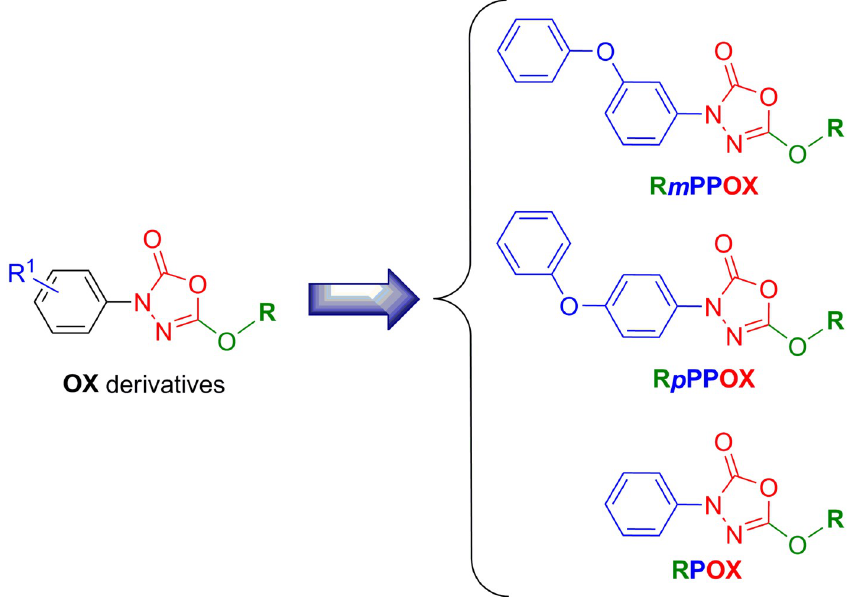
Fig 1. Chemical structure of the OX derivatives. R m (or p ) PPOX nomenclature is as follows: m (or p ) P represents the meta (or para )-Phenoxy group when present; P the phenyl group; OX the Oxadiazolone core; and R the alkyl chain ( i . e ., M ; methyl, E , ethyl; B , butyl; iB , isobutyl; H , hexyl; O , octyl; Eh , 2-ethylhexyl; D , decyl; Do , dodecyl; Be , benzyloxyethyl; Me , methoxyethyl). Adapted from